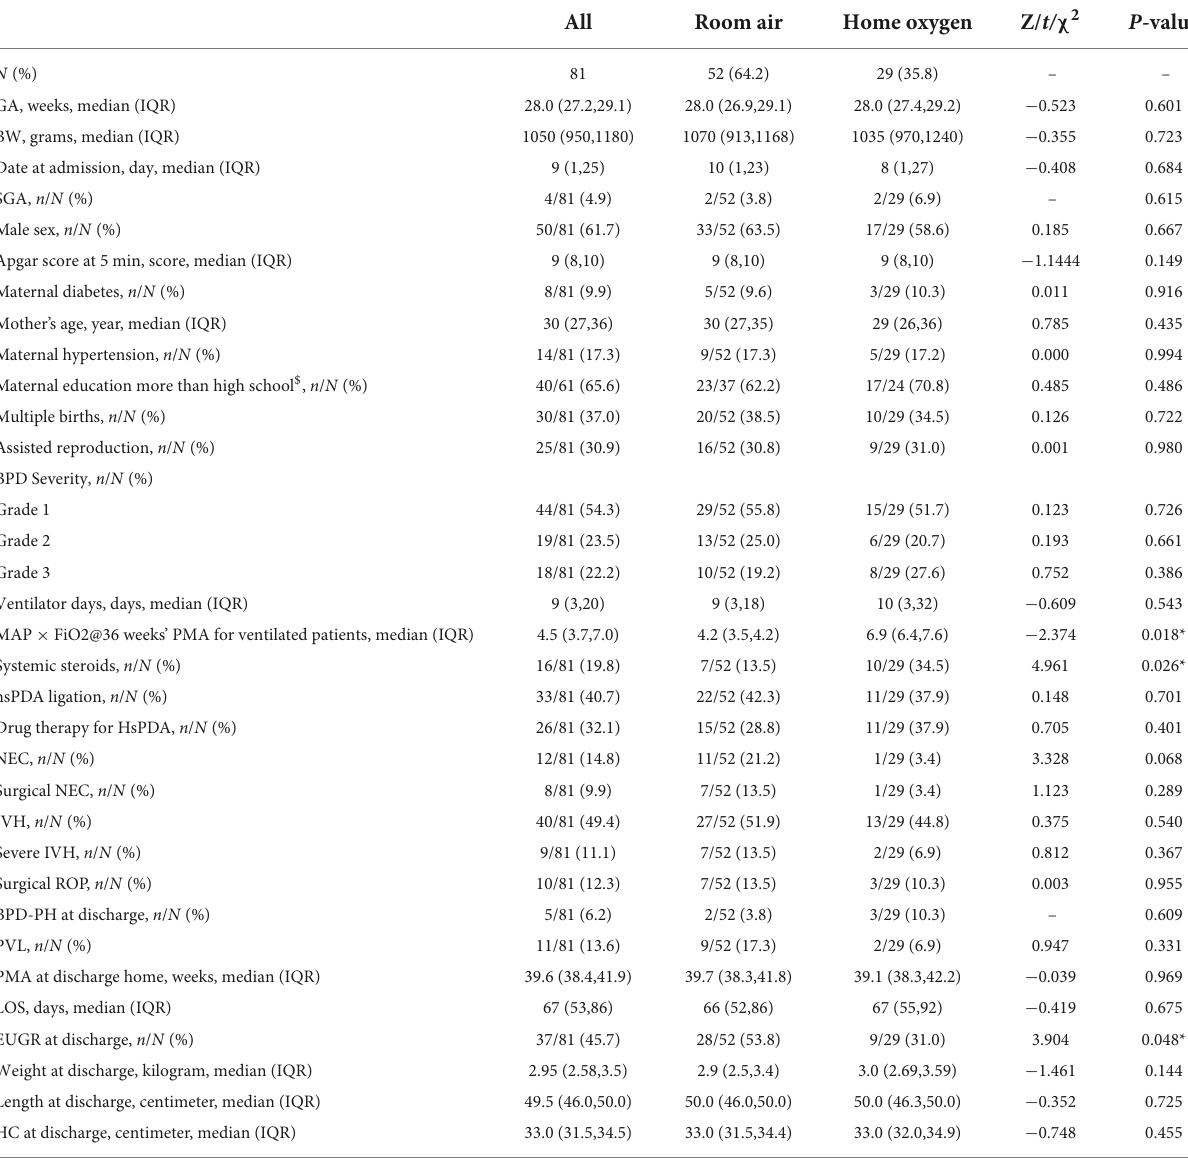
TABLE 1 Clinical and demographic characteristics of preterm infants with BPD in two groups. All Room air Home